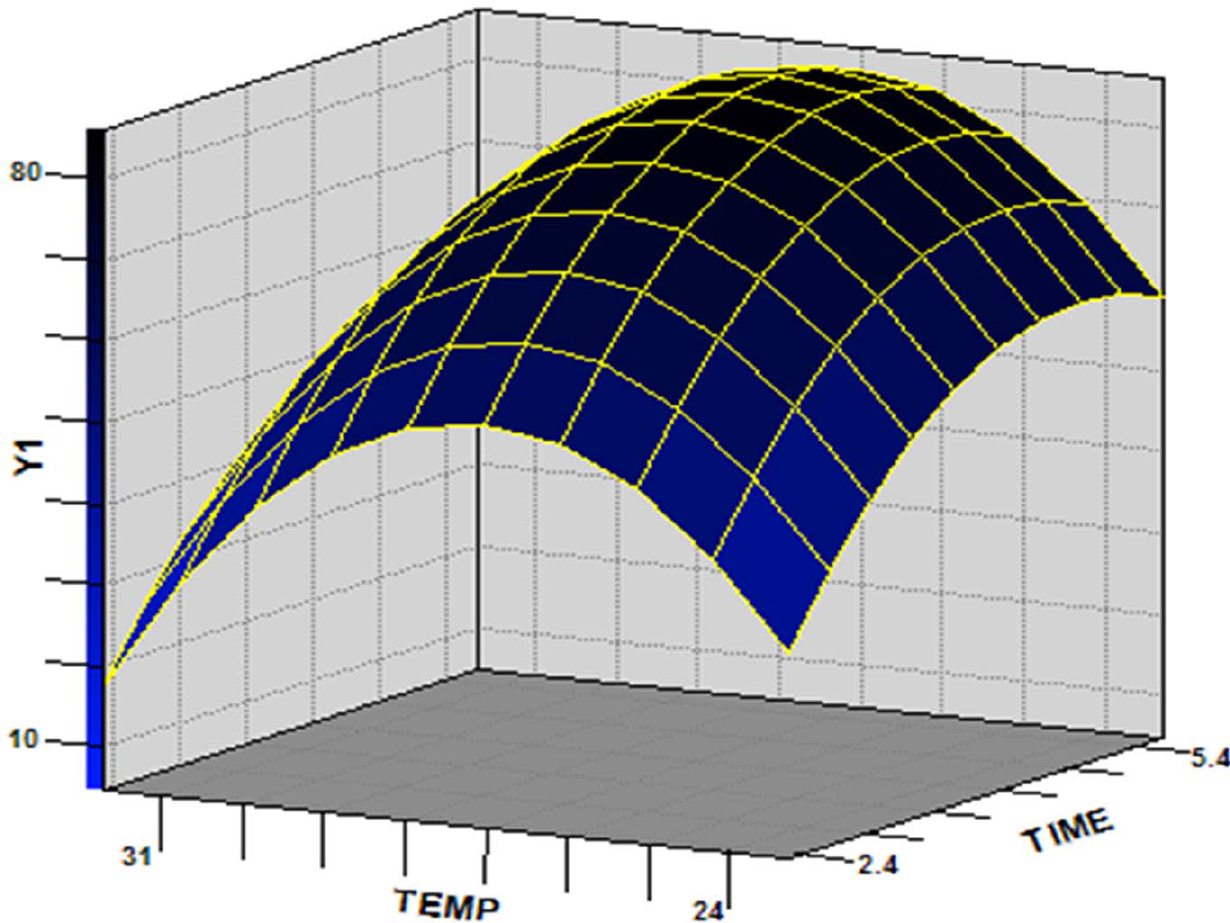
Figure 3. Response surface plot showing the effects of temperature and culture time on chlorpyrifos degradation by strain Hu-01 with pH=6.5.